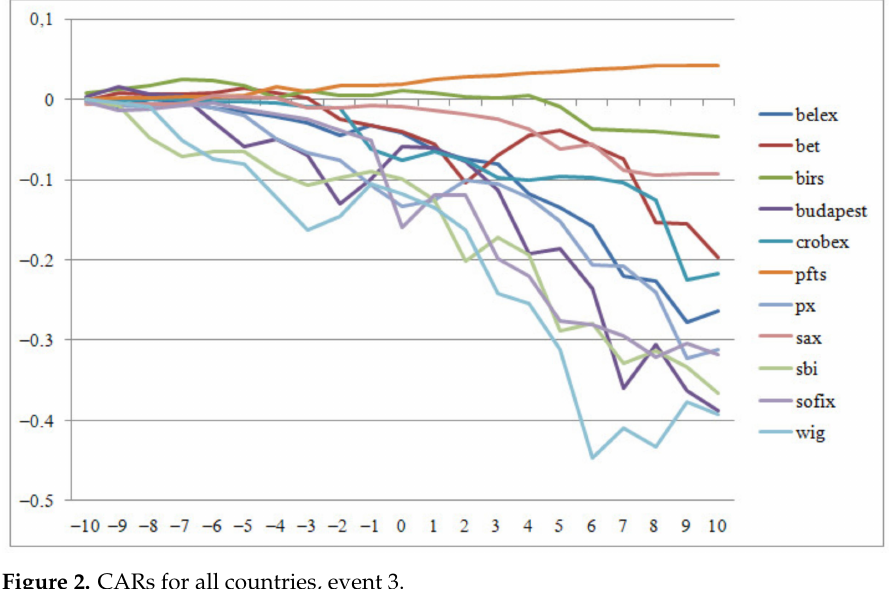
Figure 2. CARs for all countries, event 3.